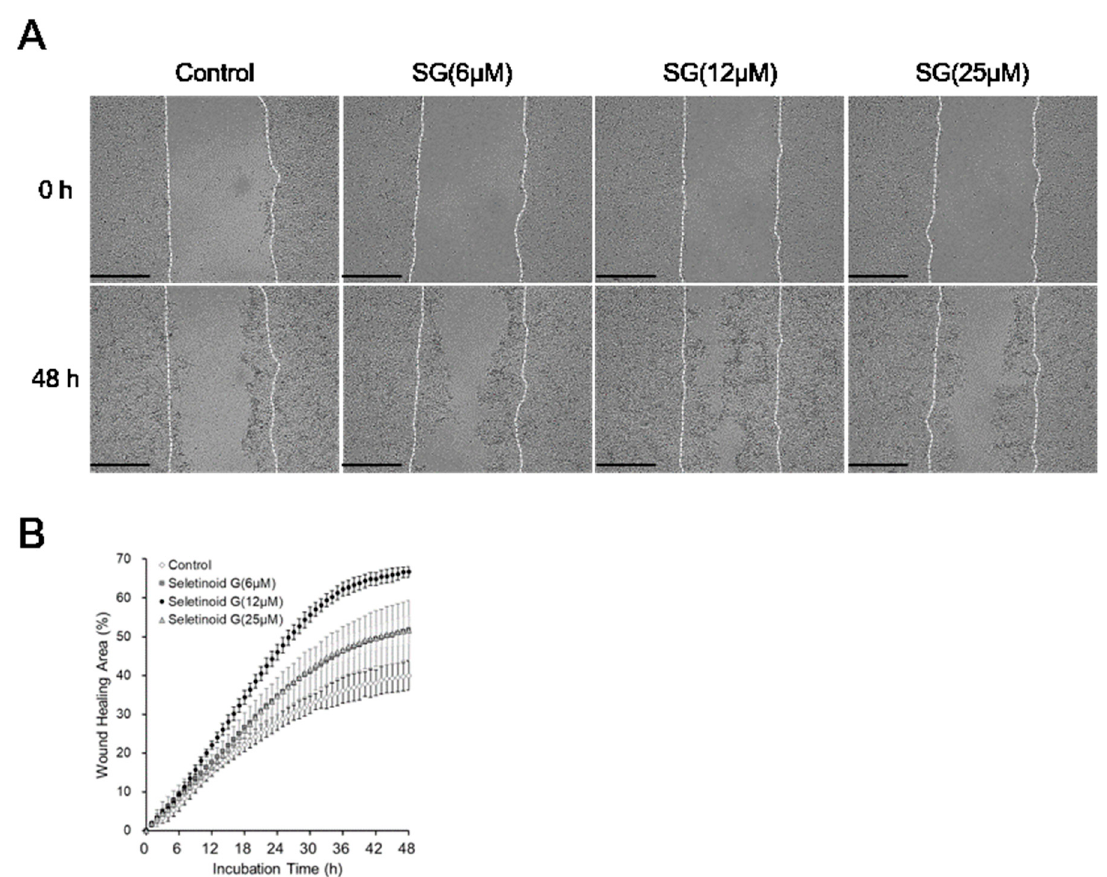
Figure 2. In vitro wound ‐ healing effect of seletinoid G on wounded HaCaT keratinocyte monolayers. ( A ) HaCaT cells were line ‐ scratched and then treated with seletinoid G (SG) at concentrations of 6, 12, and 25 μ M in Dulbecco’s modified Eagle’s medium (DMEM) containing 1% fetal bovine serum (FBS) for 48 h Scale bars indicate 500 µ m. ( B ) Each line-scratched area was automatically measured every hour for 48 h using time ‐ lapse imaging microscopy.